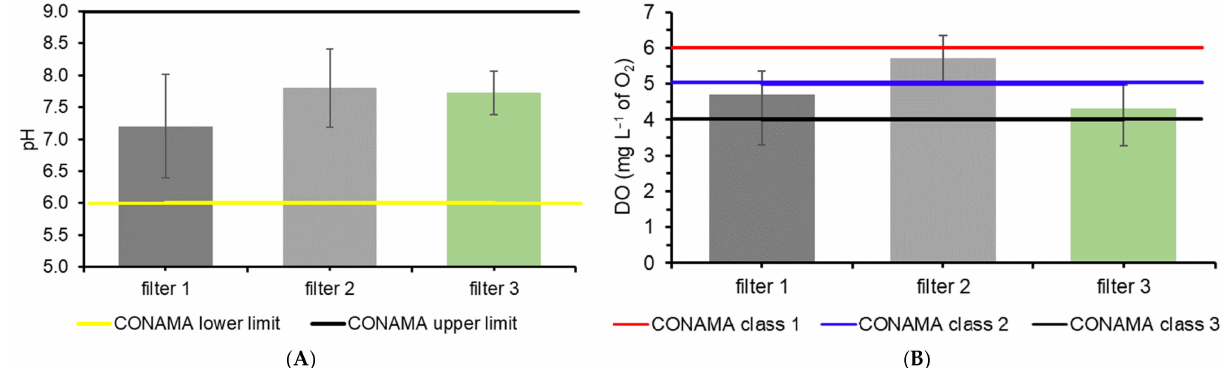
Figure 2. Means of the parameters of the three filtration systems and comparison with CONAMA Resolution No. 357: ( A ) pH values; ( B ) dissolved oxygen (DO)